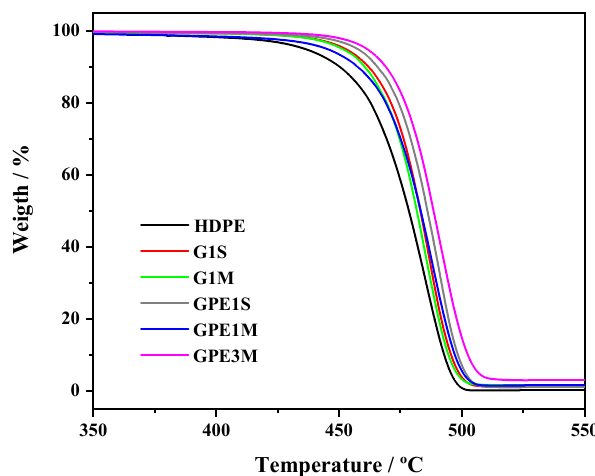
◦ C min − 1 for the di ff erent